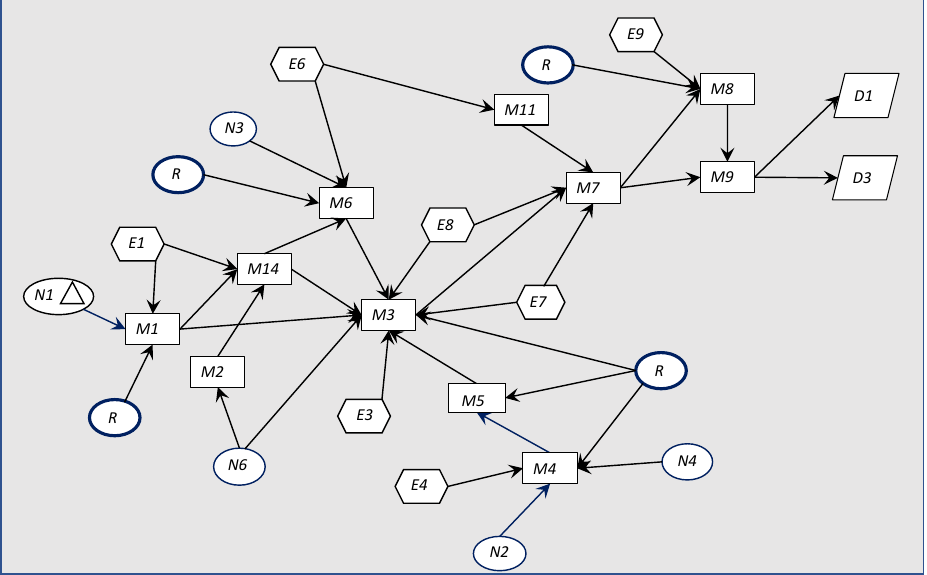
Figure 8. Multi-period design (2P,6P,12P,18P and 24P) of renewable injection into natural gas networks (pipeline distance not to scale).